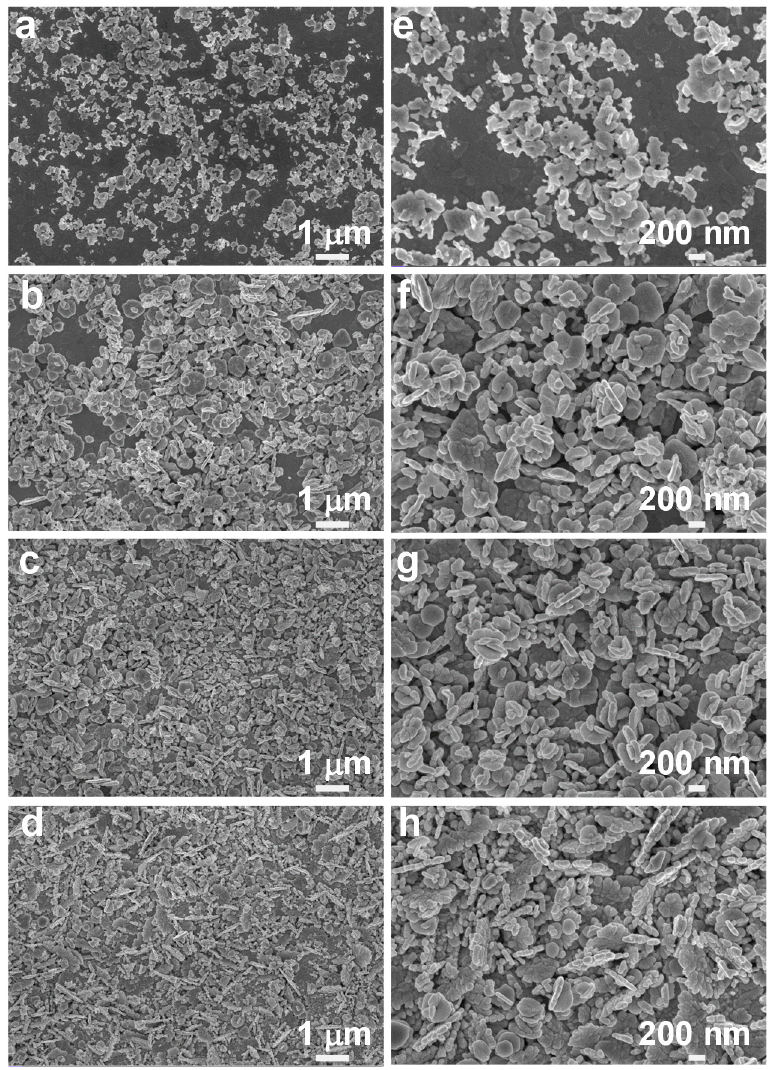
Figure 3. Low- and high-magnification SEM images of silver nanoaggregates prepared at the irradiation time of ( a , e ) 10, ( b , f ) 15, ( c , g ) 20, and ( d , h ) 25 min, respectively, at a fixed irradiation intensity of 4.5 × 10 5 W/cm 2 .